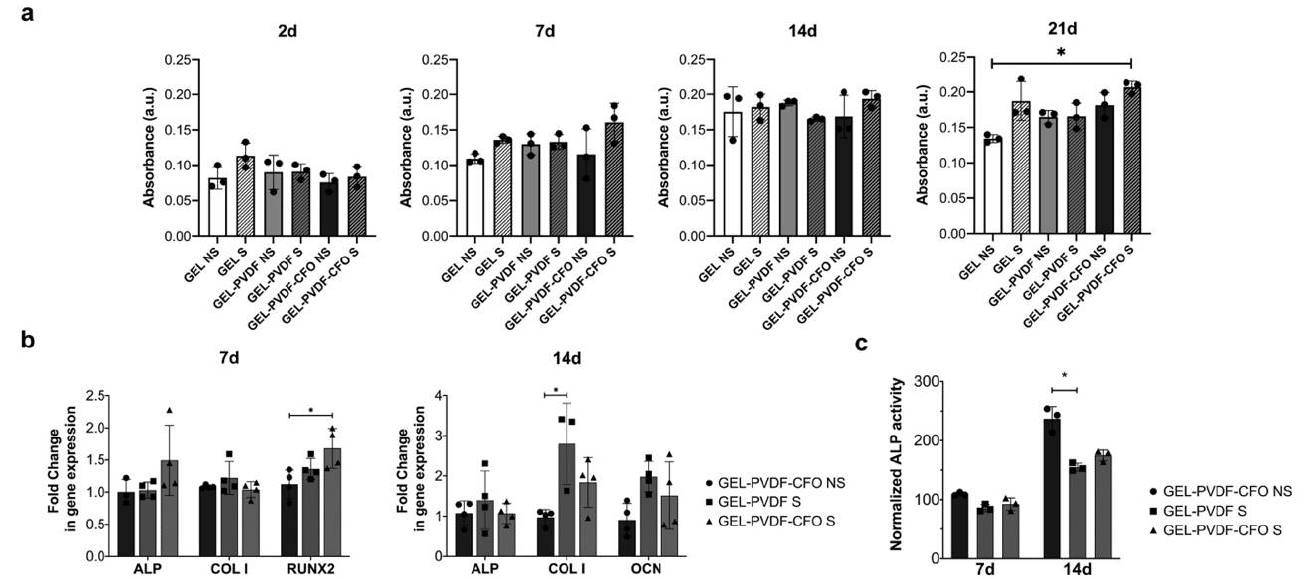
Figure 4. Effect of electromechanical stimulation on MSCs proliferation and differentiation in non- stimulated (NS) and stimulated (S) conditions. ( a ) MTS assay at short and long term (2, 7, 14 and 21 days). Graphs show significant differences for each time point between different hydrogel compositions ( n = 3). Differences between time points for the same hydrogel composition were also assayed, but no significant changes were found. ( b ) Relative gene expression of characteristic osteogenic markers (Alkaline phosphatase (ALP), collagen type I (COL I), runt-related transcription factor 2 (RUNX2) and osteocalcin (OCN)) after 7 and 14 days of culture ( n = 4). Glyceraldehyde- 3-phosphate dehydrogenase (GAPDH) was used to normalise gene expression ( c ) ALP activity determination after 7 and 14 days of culture ( n = 3). Circles correspond to data collected for Gel- PVDF-CFO NS, squares for Gel-PVDF S and triangles represent Gel-PVDF-CFO S samples, for both (b) and (c) graphs. All statistical differences were determined by non-parametric Kruskal-Wallis and Dunn’s multiple comparison test. * indicates p -value < 0.05.